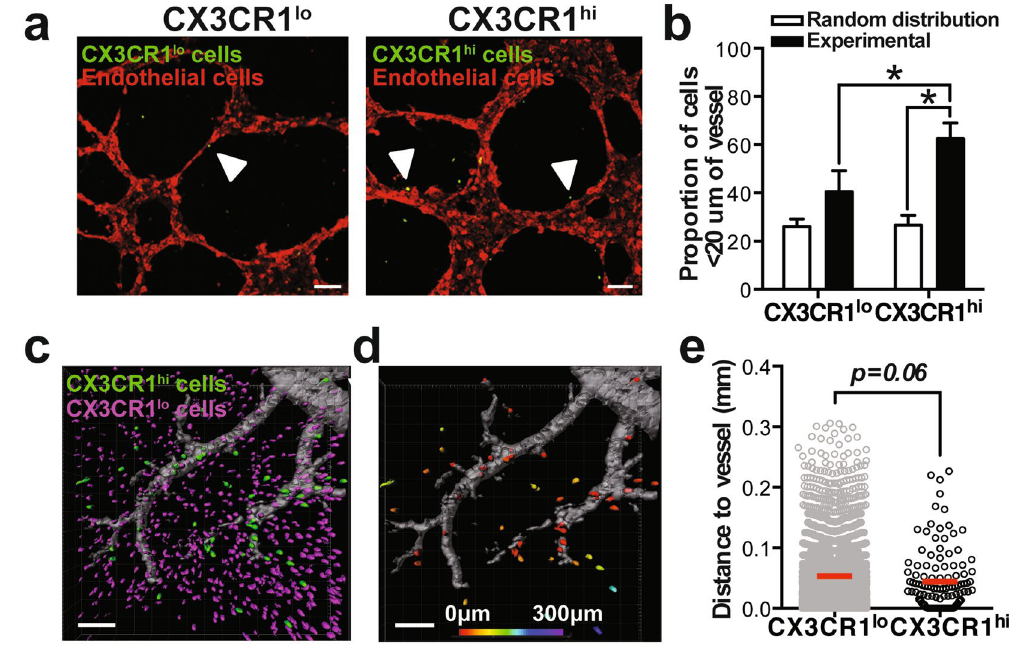
Figure 7. Non-classical monocytes localize to a perivascular niche. ( a ) Sorted CX3CR1 lo and CX3CR1 hi mouse monocytes associate with murine endothelial cell networks in vitro (solid white arrows) ( b ) The proportion of experimental CX3CR1 hi monocytes within 20 µ m of the vessel network compared to CX3CR1 lo monocytes and a model-simulated random distribution of cells. Data presented as mean ± S.E.M. Statistical analyses were conducted using two-way ANOVA. * p < 0.05, n = 3 independent experiments. (c) Intravital imaging of CX3CR1 lo and CX3CR1 hi cells around PLGA implants in DWC mice 1 day post-surgery. (d,e) Distance of CX3CR1 lo and CX3CR1 hi cells to closest to blood vessel. Vessels were labeled with i.v. injection of rhodamine- dextran. Statistical analysis was performed using two-tailed Mann-Whitney test. * p < 0.05, n > 100 cells, across 3–4 animals per group. Scale bars, 100 µ